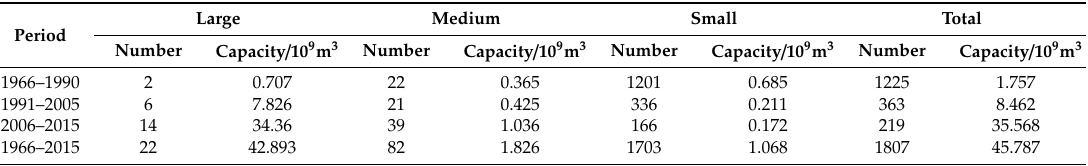
Table 5. Statistics of reservoirs built in the Jinsha River Basin from 1966 to